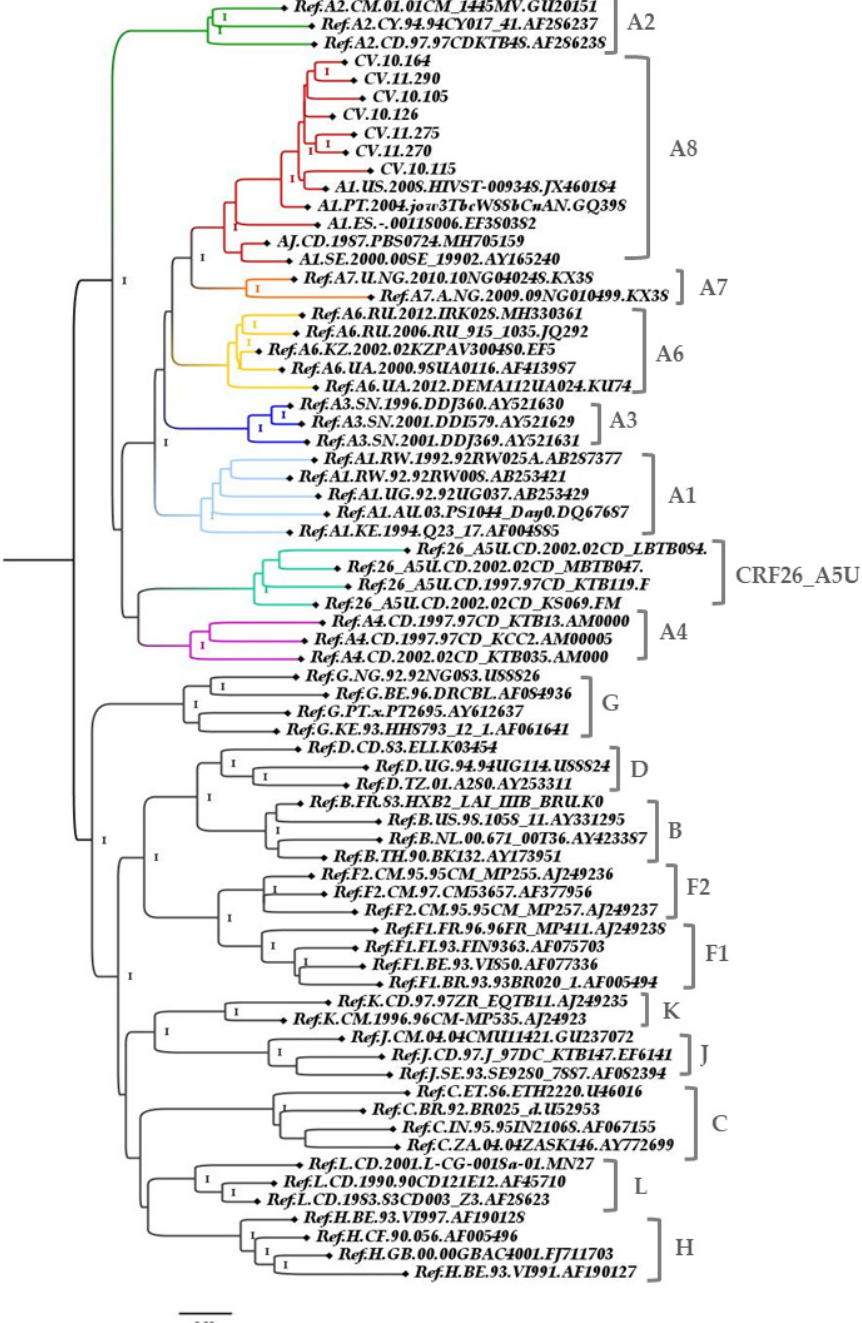
Figure 3. ML tree implementing nucleotide substitution model GTR, indicating the phylogenetic relationships between A sub-subtypes. ALRT values are represented only if > 0.90. Pol fragment (2253–3218 relative to the HXB2 reference). The sub-subtype A branches are